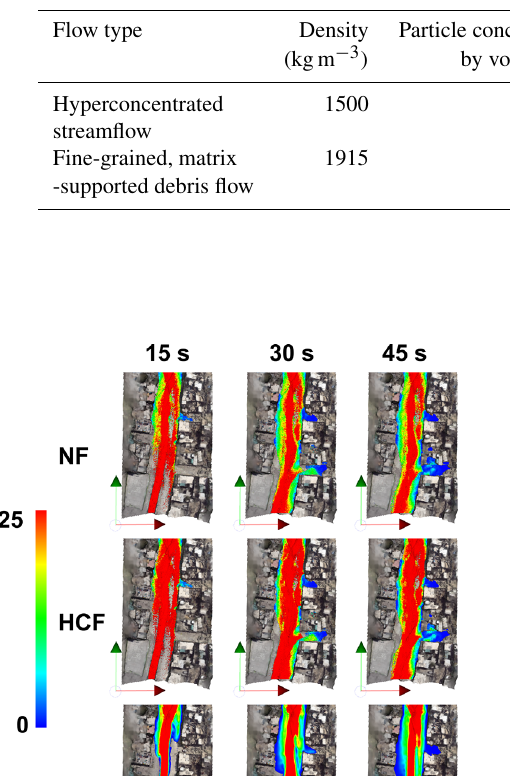
Table 3. Density, particle concentration and rheology coefficients for hyperconcentrated streamflow and debris flow simulations, taken from Govier et al. (1957), Julien and Lan (1991).